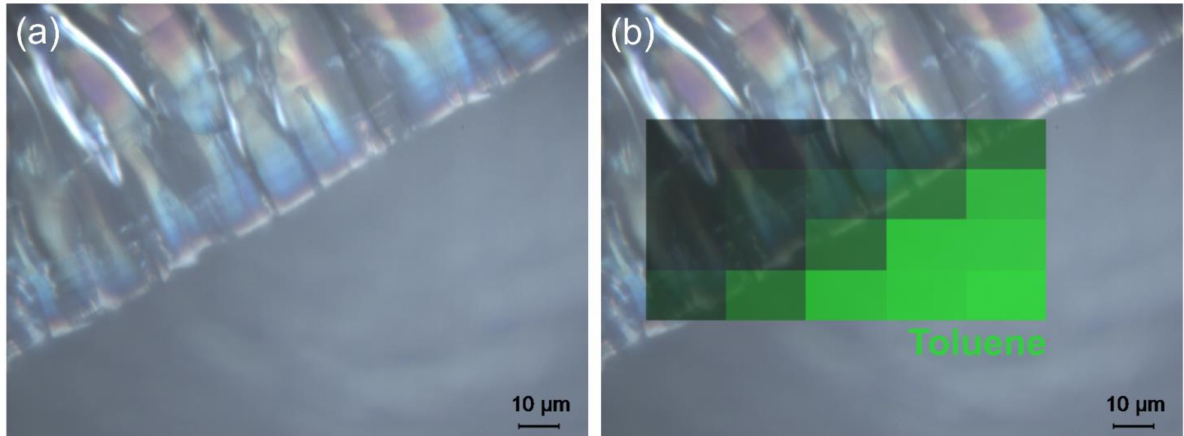
Figure 4. ( a ) Reflected light micrograph of sample USNM 1226533, Cateria gerlachi , without and ( b ) with a Raman distribution map of toluene overlaid (based on the intensity of the most prominent